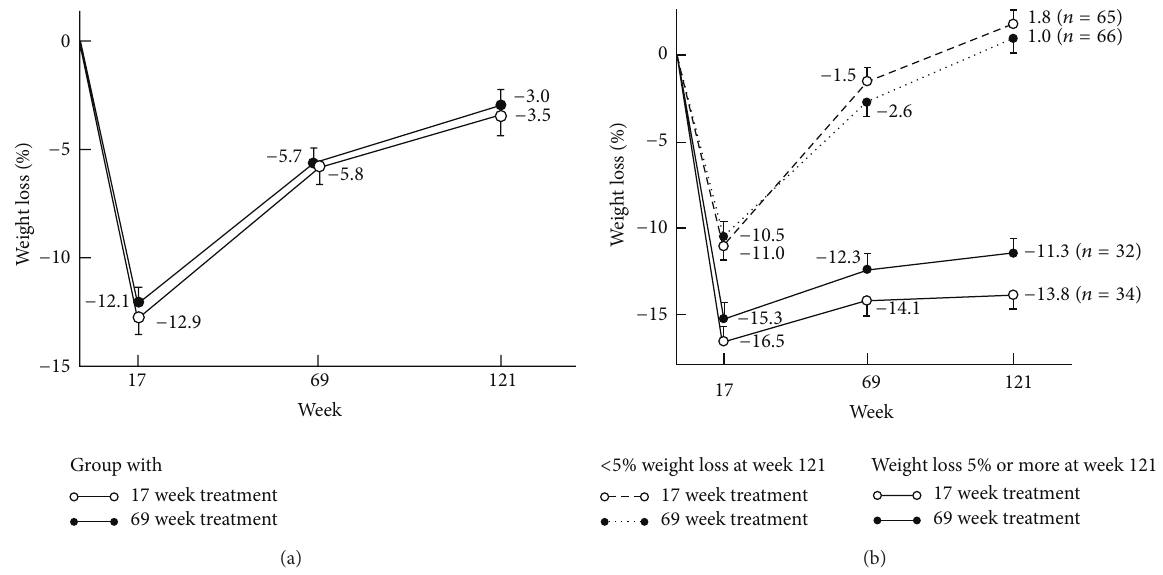
Figure 2: (a) Mean (SE) percentage change from baseline in weight over 121 weeks in the treatment groups. (b) Mean (SE) percentage change from baseline in weight over 121 weeks in the treatment groups according to the final outcome, weight loss ≥ 5% or < 5% at week 121.